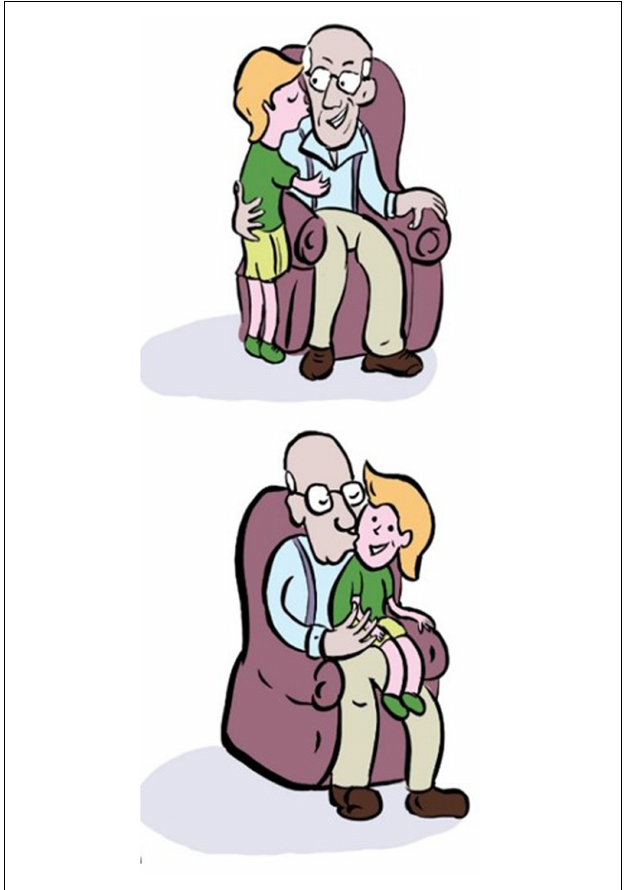
FIGURE 1 | An example for a picture pair used in Experiment 1. Das ist der Junge der den Opa küsst That is the MASC , NOM boy who MASC , NOM the MASC , ACC grandfather kissed. ‘That’s the boy who kissed the grandfather’